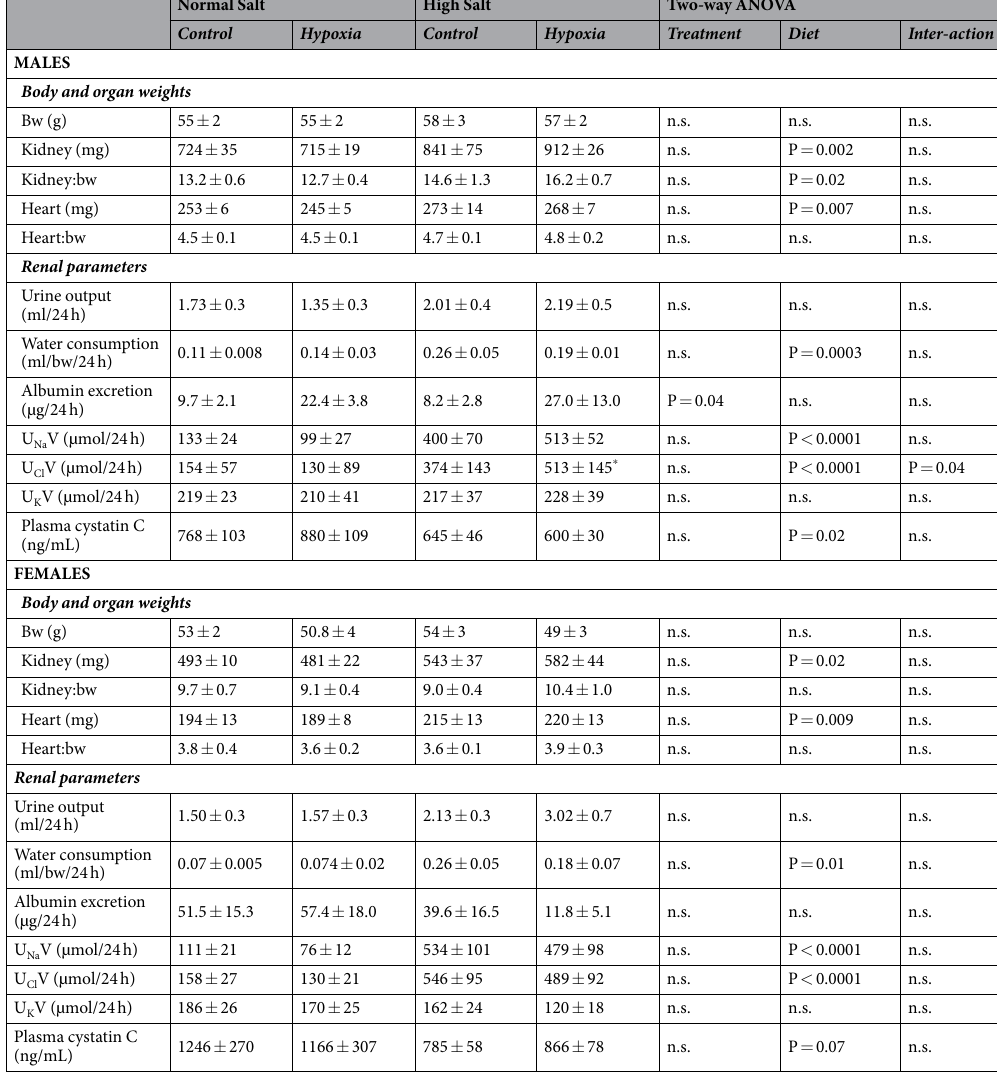
Table 2. Offspring body and organ weights and renal parameters at 12 months of age. Values are mean ± SEM. Body weight (bw). Body/organ weights: N = 1–2 offspring from 11 litters/group. Renal parameters: male, N = 6–10/group; female, N = 5–10/group. Effect of treatment, diet or interaction (treatment x diet) was evaluated by two-way ANOVA. * Sidak post hoc comparing control/hypoxia offspring fed the high salt diet. Not significant